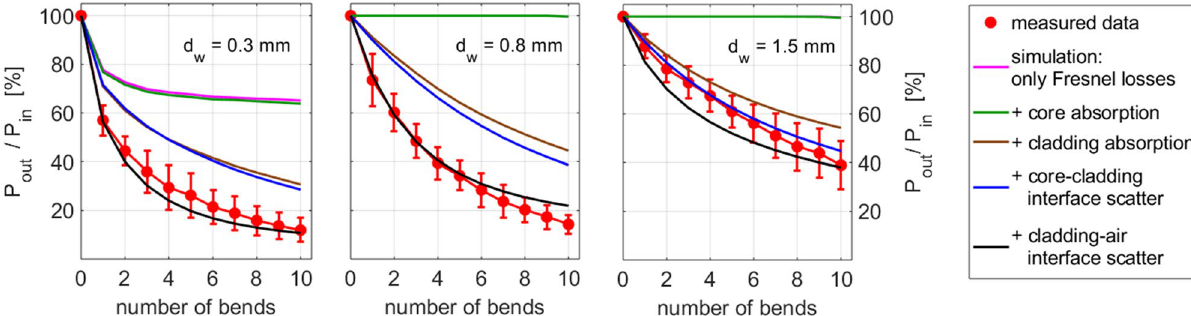
Figure 6. Comparison of the experimental bend losses (red circles: mean with s.d., n = 10; red line only to guide the eye) of fibre 1143 for three wire diameters d w with models incorporating different loss mechanisms. Pink line: model incorporating only Fresnel losses; green line: model incorporating Fresnel losses and core absorption; brown line: model incorporating Fresnel losses and core and cladding absorption; blue line: model incorporating all previous mechanisms plus the scattering at the core-cladding interface; black line: complete model incorporating all 5 loss